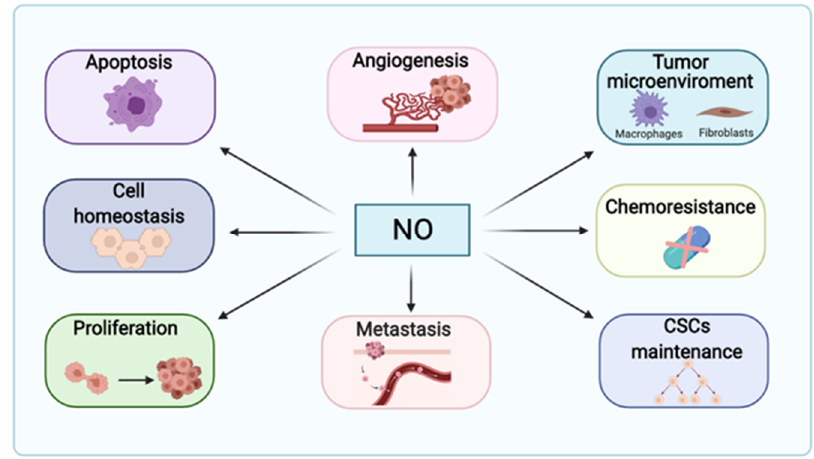
Figure 1. Implication of nitric oxide (NO) during carcinogenesis. Although NO is relevant for homeostasis, it may influence cell proliferation, metastasis potential, cancer stem cells (CSCs) maintenance and renewal, chemo- and apoptosis resistance, as well as modulating the tumor microenvironment and angiogenesis according to its concentration-, time- and compartment-dependent gen- eration.